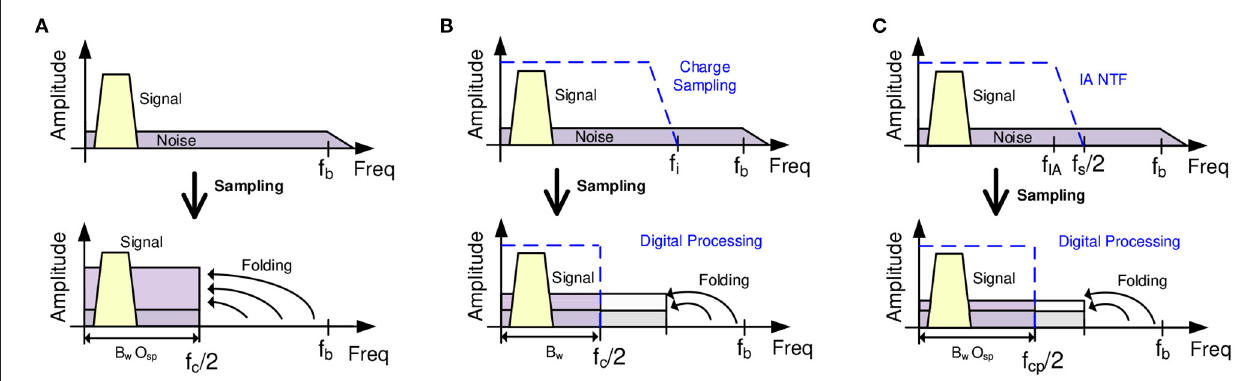
FIGURE 10 | Illustration of the noise folding problem in TDM AFEs. (A) Noise folding problem in multiplexing circuits. (B) Noise folding in multiplexing circuits applying charge sampling techniques. (C) Noise folding in multiplexing circuits applying a narrow-band CDS